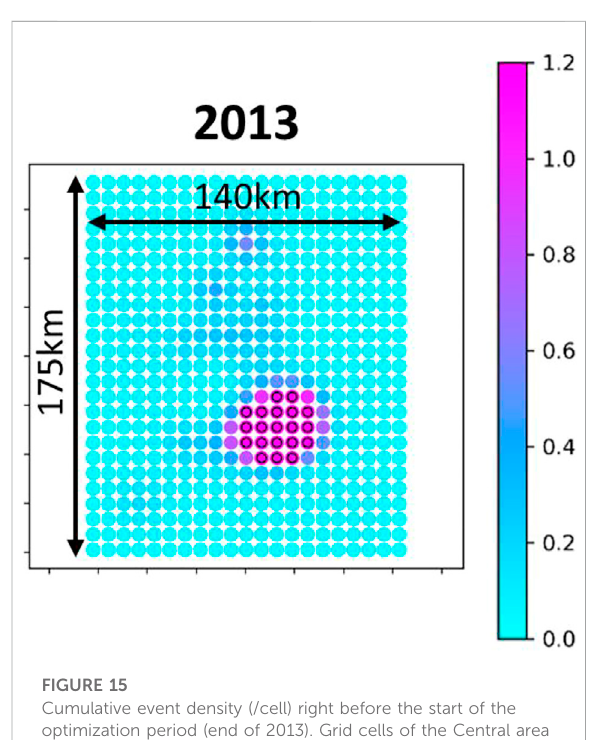
Cumulative event density (/cell) right before the start of the optimization period (end of 2013). Grid cells of the Central area with a number of events higher than 1.0 are underlined in